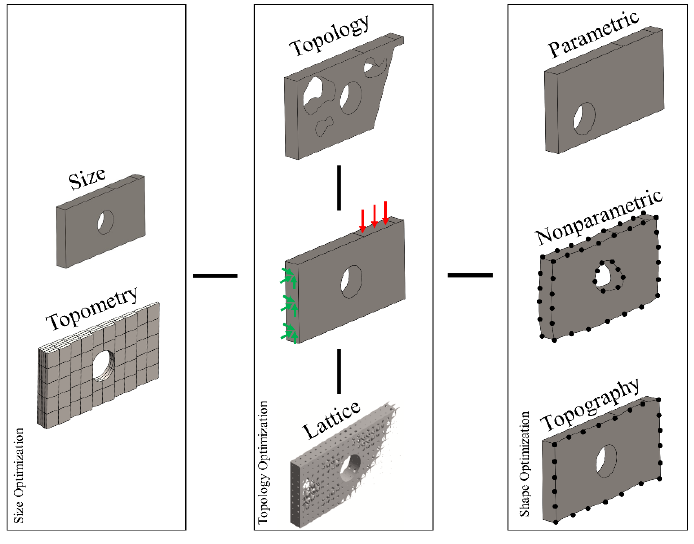
Figure 1. The different types of SO adapted from [5] .